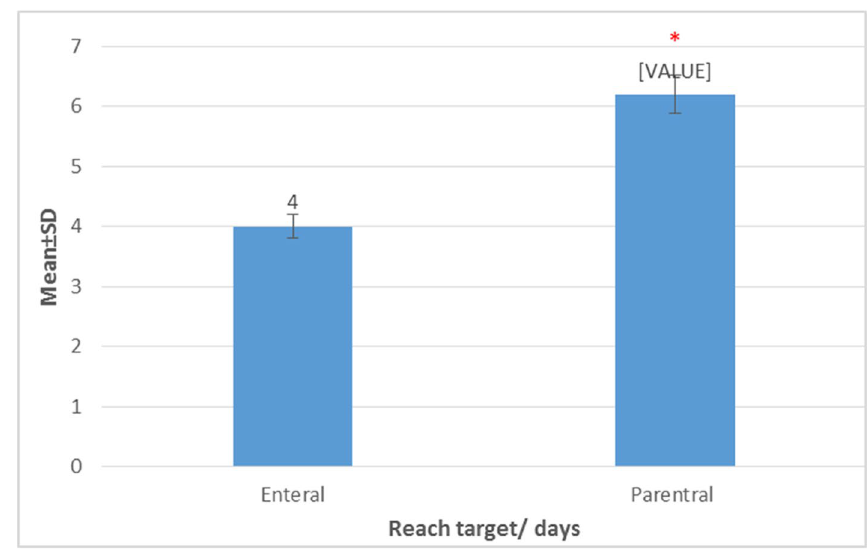
Fig. 2 Comparison between both groups as regard time to reach caloric